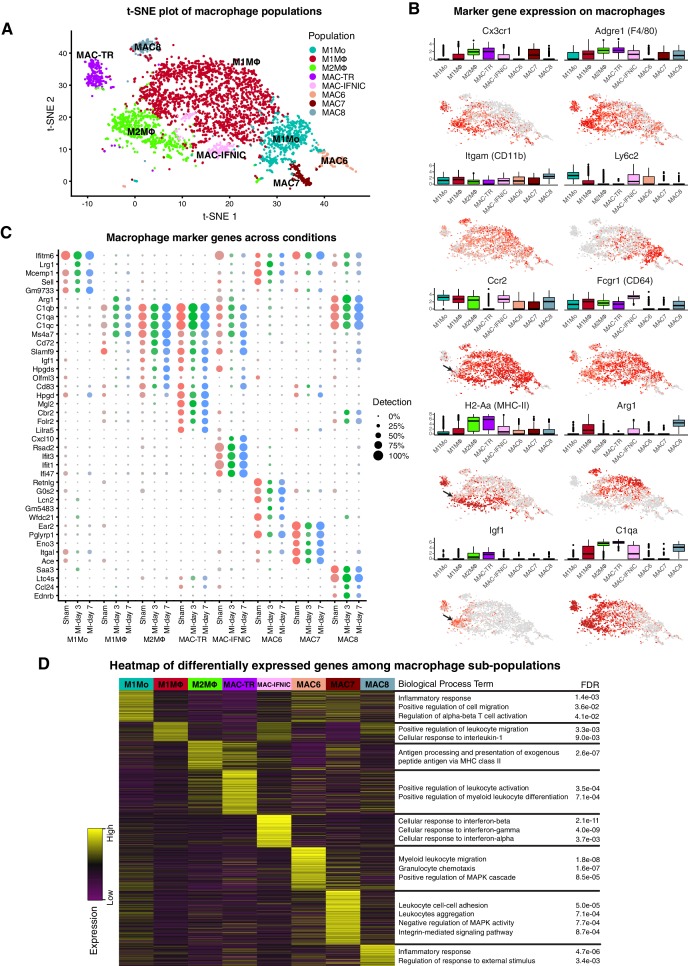
Cardiac Mo/MΦ populations.(A) t-SNE plot showing extracted Mo/MΦ populations. (B) Expression of select immune cell markers as visualized in box-plots and t-SNE plots. Arrows indicate Ccr2low sub-population of M2MΦ. (C) Dot-plot of top upregulated genes for each Mo/MΦ population where color indicates experimental conditions. (D) Heatmap of differentially expressed genes between Mo/MΦ populations with representative significant GO Biological Process terms.